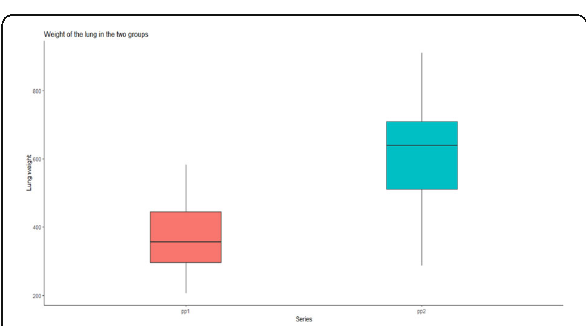
Fig. 2 (abstract 001595). See text for